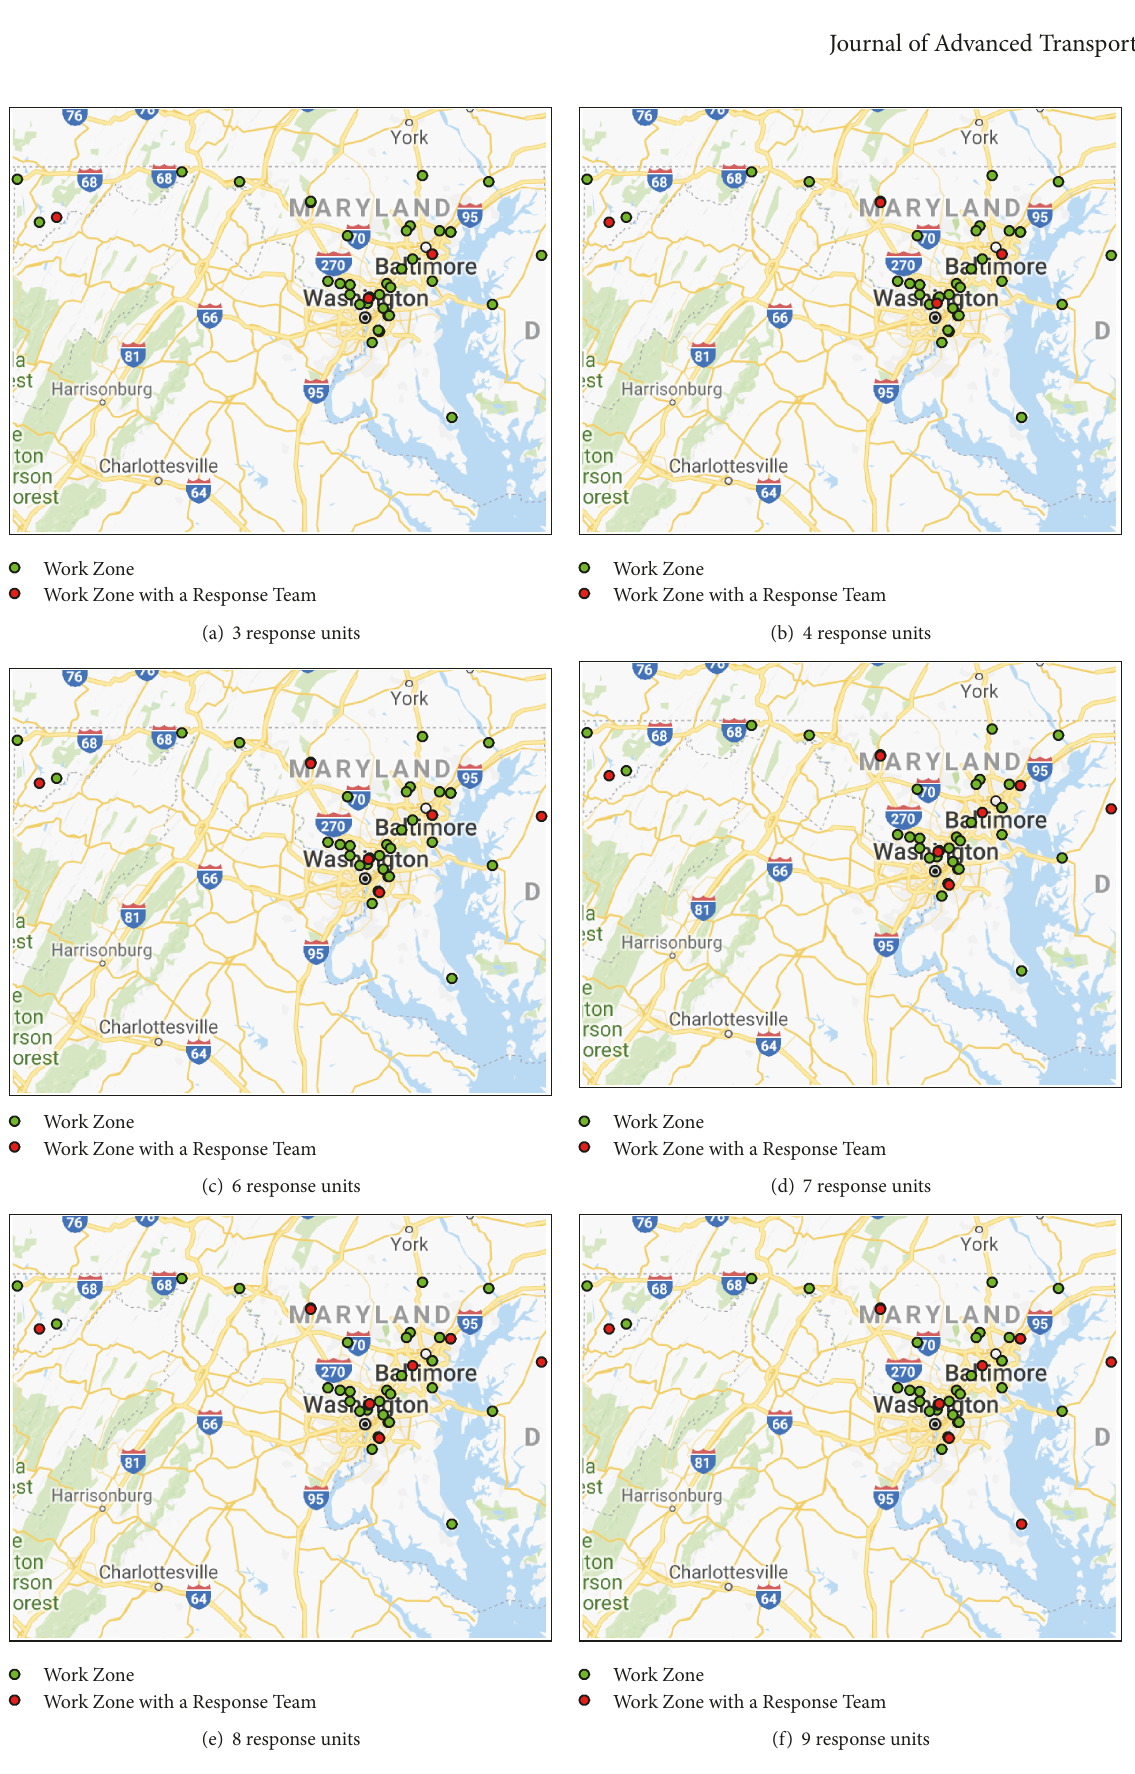
Figure 14: Sensitivity analysis showing the optimal allocation of response teams when the number of available units is perturbed from 𝑚 = 5